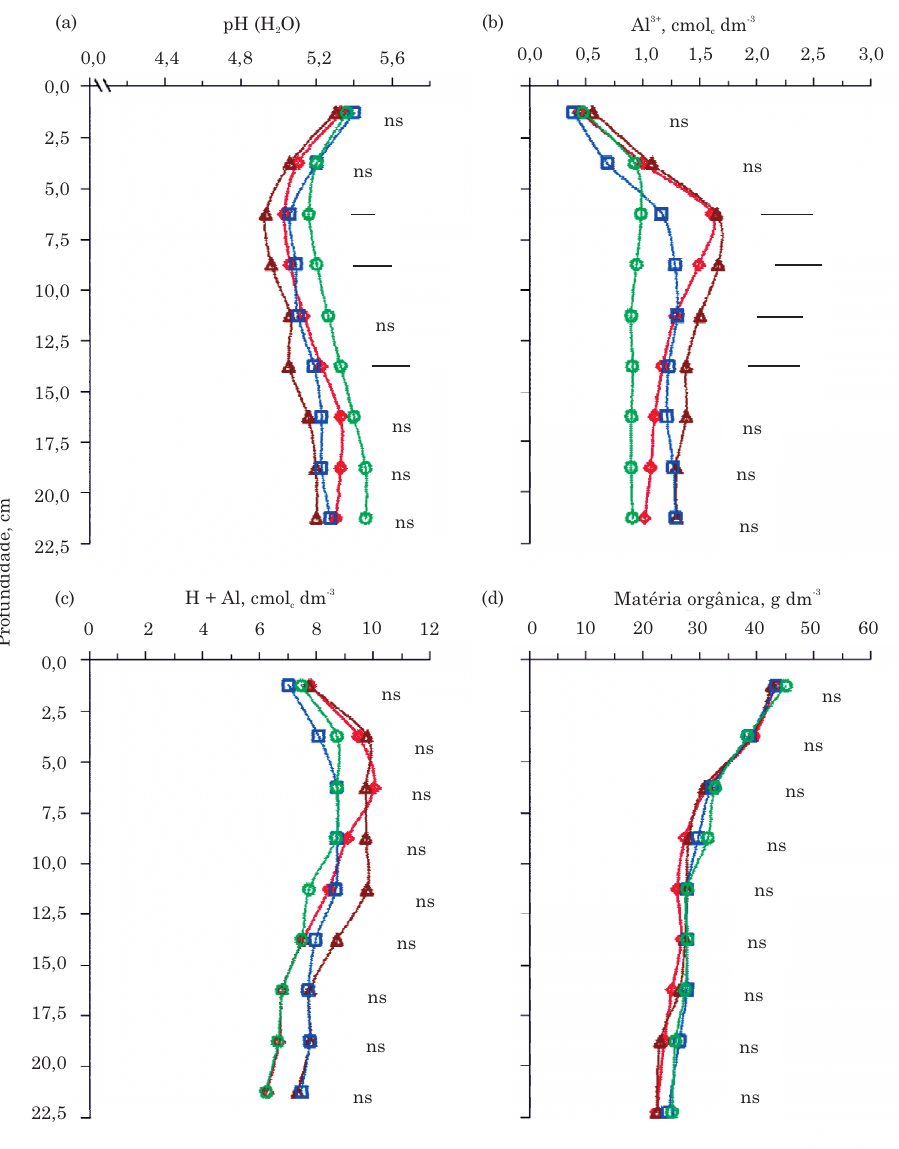
Figura 4. pH em água (a), alumínio trocável (b), acidez potencial (c) e matéria orgânica (d), oito meses após a semeadura do milho ( Zea mays L.), com semeadora equipada com haste sulcadora ajustada para operar a diferentes profundidades, em Latossolo Vermelho sob plantio direto, obtidos na linha de semeadura. T 1 : ação da haste sulcadora a 5 cm; T 2 : ação da haste sulcadora a 10 cm; T 3 : ação da haste sulcadora a 1 5 cm; e T 4 : ação da haste sulcadora a 17 cm; Barras horizontais representam a